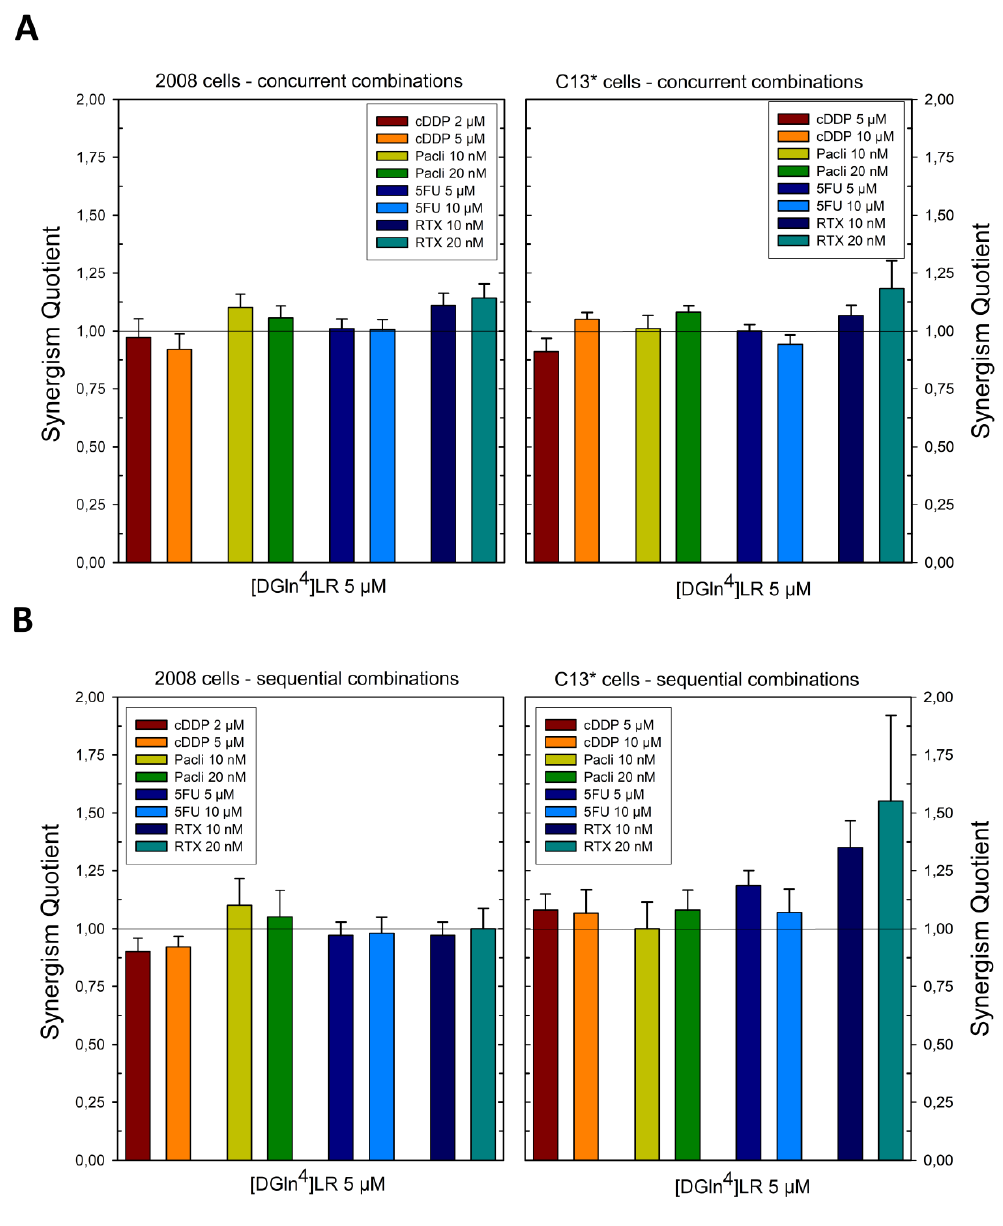
Figure 2. Effects of scheduled combinations of [DGln4]LR peptide with cDDP, paclitaxel, 5FU and RTX on the SQ values in 2008 and C13* cell lines. ( A ) concurrent combinations for 72 h. ( B ) Sequential combinations as described in Section 4. The bars represent the mean of duplicate cell counts on three separate experiments and indicate the results of the inhibition of drug combinations divided by the sum of the inhibition of a single drug to obtain the values of SQ. Error bars, SD.